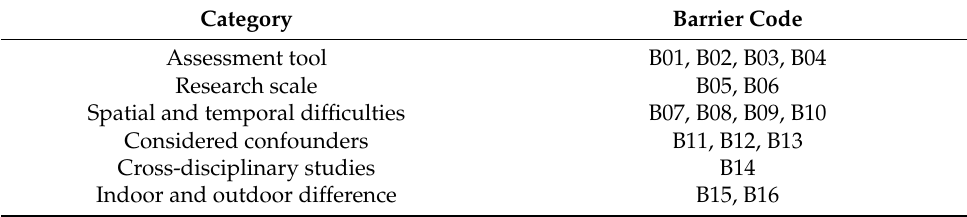
Table 6. The Categories of Determined